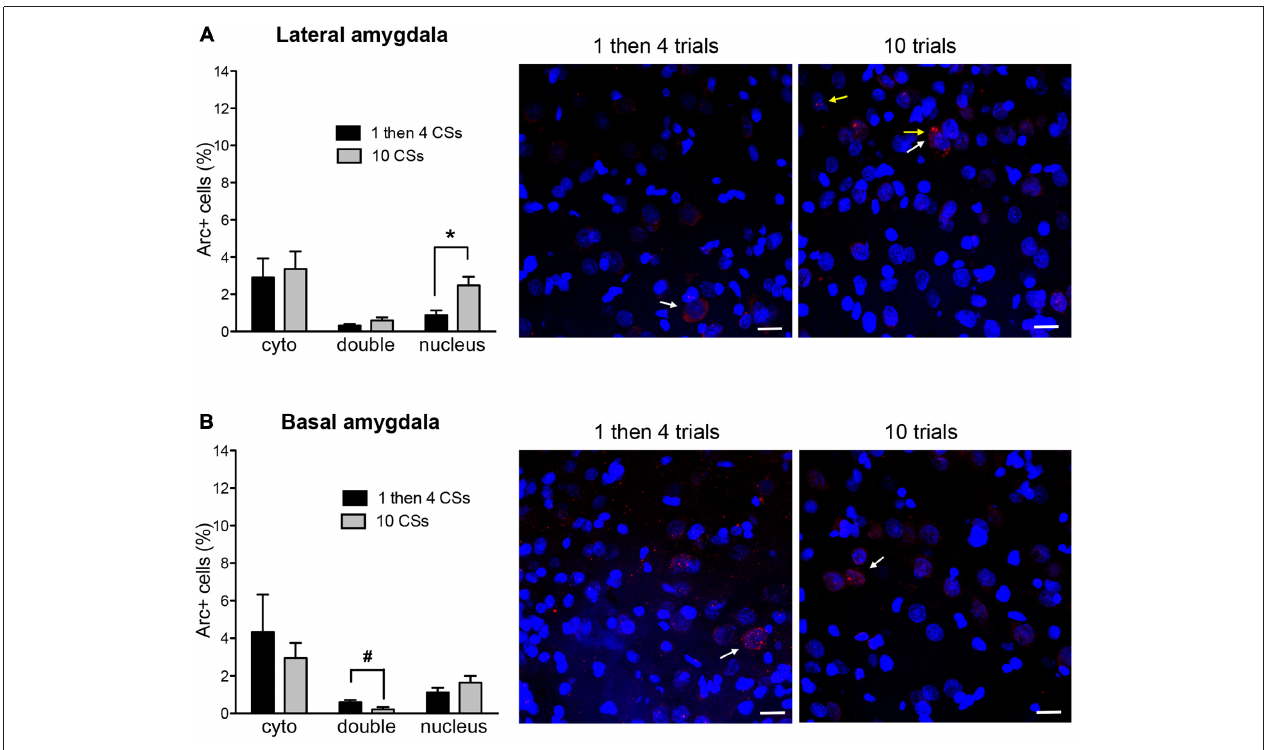
FIGURE 4 | The bar graphs show percentage of DAPI+ cells expressing Arc mRNA in the cytoplasm (cyto), nucleus, or both (double) in lateral nucleus (A) and basal nucleus (B) of the amygdala. The photomicrographs are maximum intensity projections of representative z -stacks from the sampled regions in the amygdala. DAPI+ cells are shown in blue and Arc mRNA are shown in red. The yellow arrows point to Arc foci in the nuclei and the white arrows point to the Arc in the perinuclear areas (cytoplasm). Scale bar = 20 µ m. * p < 0.05, # p =